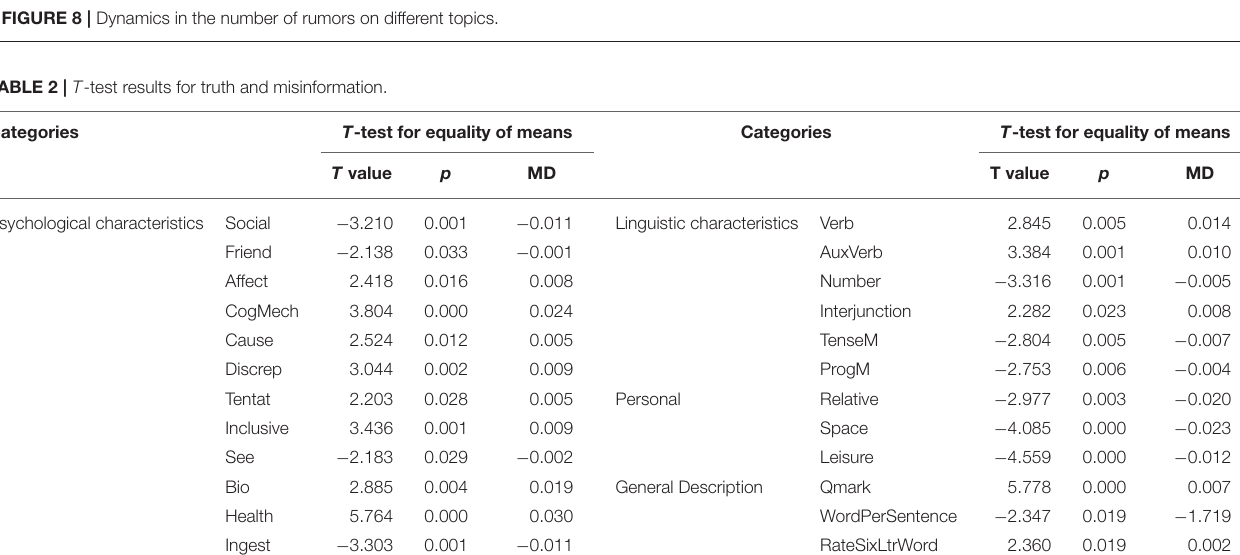
FIGURE 8 | Dynamics in the number of rumors on different topics.